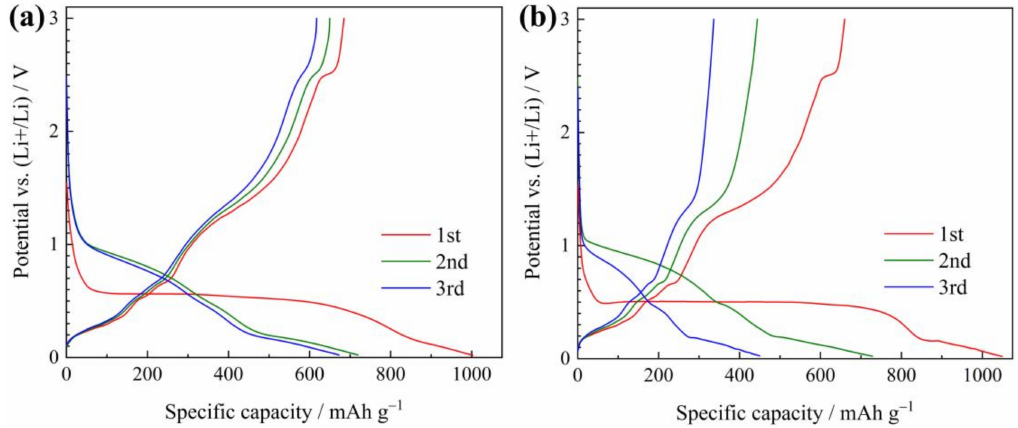
Figure 4. Galvanostatic discharge–charge curves of ( a ) ZnO / Ni and ( b ) ZnO